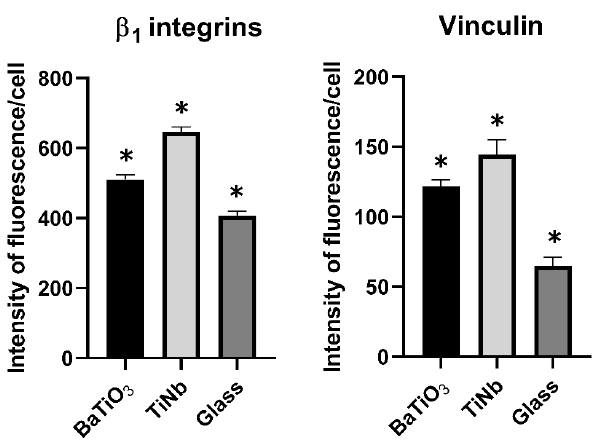
Figure 10. Intensity of immunofluorescence of molecules involved in cell adhesion, i.e., β 1 -integrin adhesion receptors and vinculin, normalized to the cell number on the Ti39Nb alloy coated with BaTiO 3 (BaTiO 3 ), on bare Ti39Nb alloy (TiNb), and on control microscopic glass coverslips (Glass). Mean + S.E.M. from 16 microphotographs for each experimental group. ANOVA, Student-Newman-Keuls Methods. Asterisks above the columns indicate experimental groups significantly differing ( p ≤ 0.05) from the other groups.